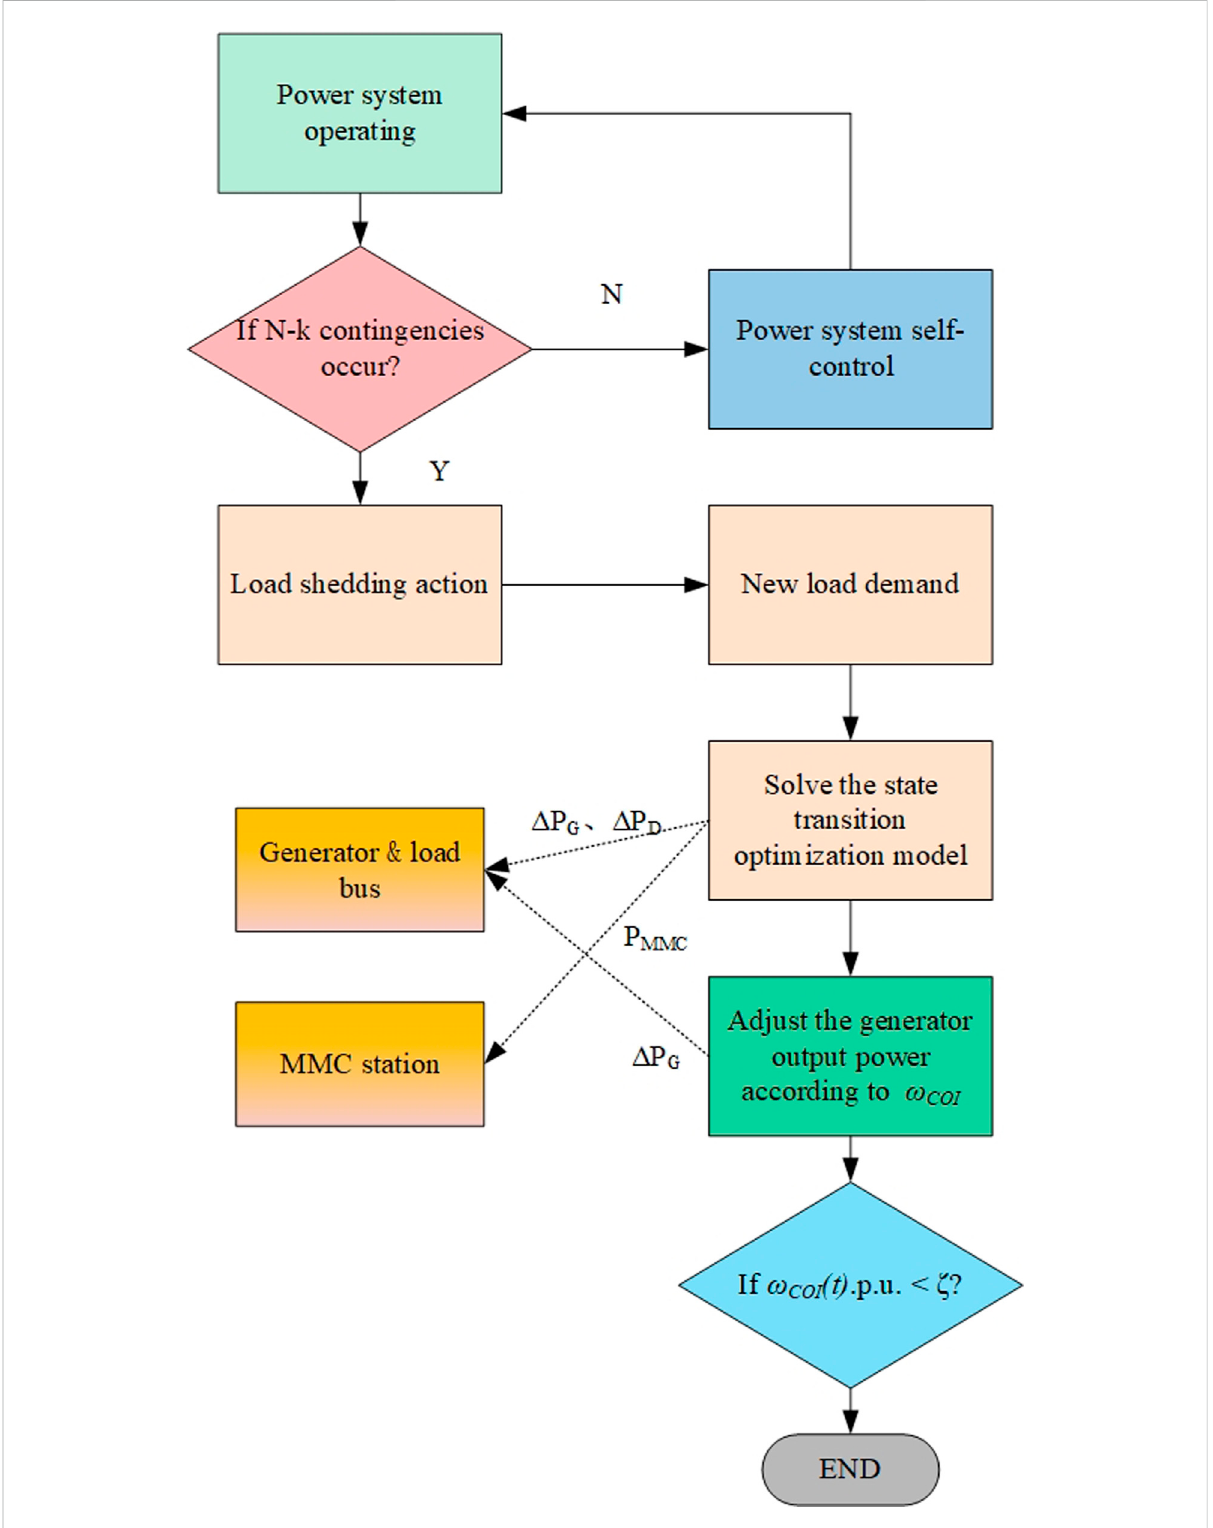
FIGURE 4 Flowchart of the control